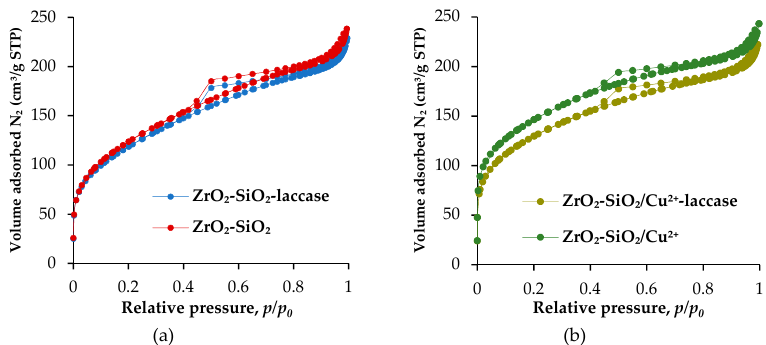
Figure 4. Low temperature N 2 adsorption/desorption isotherms of: ( a ) ZrO 2 –SiO 2 , ZrO 2 –SiO 2 –laccase and ( b ) ZrO 2 –SiO 2 /Cu 2+ and ZrO 2 –SiO 2 /Cu 2+ –laccase systems. Table 1. Parameters of the porous structure of the obtained materials before and after immobilization of laccase.